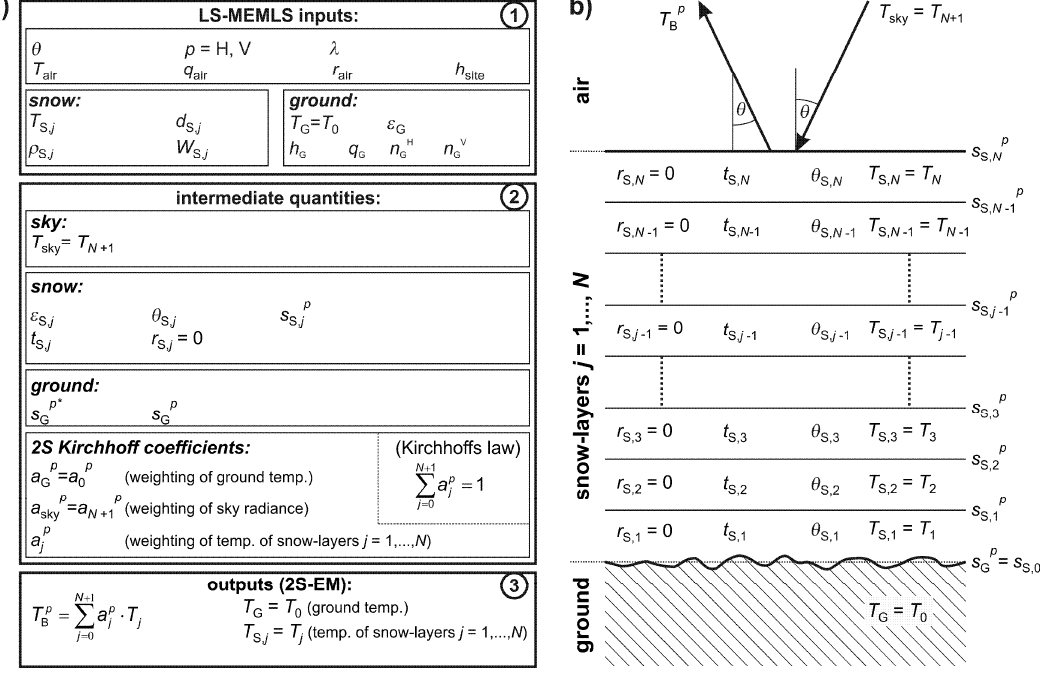
Figure 9. ( a ) Block diagram of the L-band Specific Microwave Emission Model of Layered Snowpacks (“LS—MEMLS”) used to simulate L-band brightness temperatures T p over snow covered grounds; and ( b ) sketch of the two-stream emission model (2S-EM) employed in “LS—MEMLS”. Symbols and model components are explained in the text.